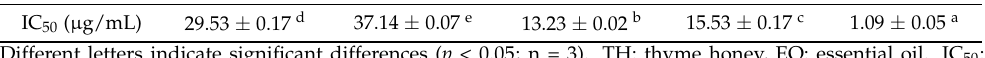
Table 10. Anti-inflammatory activity of Thyme honey and EOs of M. spicata , O; vulgare, and E. globulus .